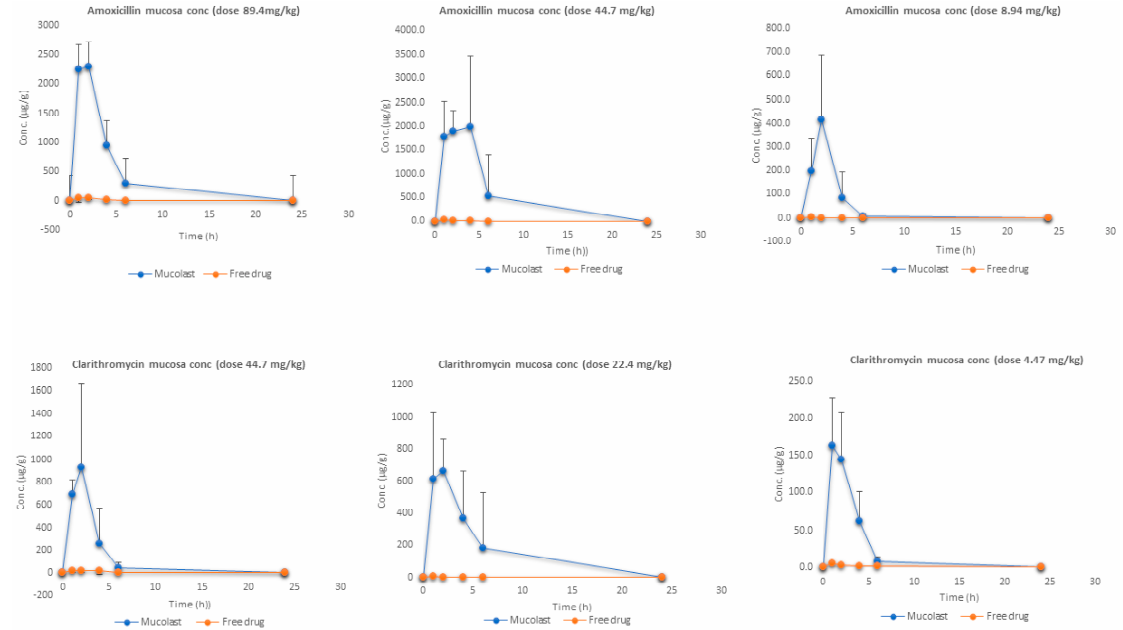
Figure 3. Amox and Clar mucosa levels after the administration of antibiotics in Mucolast ® or saline solution at three different doses. Table 6. Amox and Clar AUC mucosa values after the administration of antibiotics in Mucolast ® or saline solution at three different